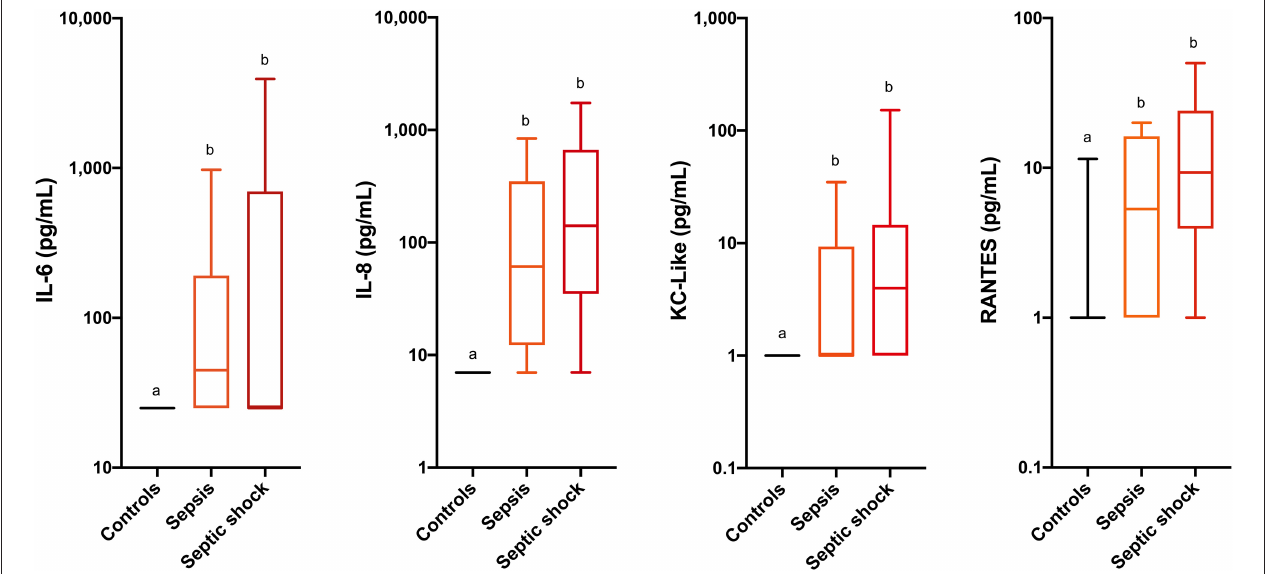
FIGURE 1 | Box and whisker plots for the concentrations of interleukin-6 (IL-6), interleukin-8 (IL-8), keratinocyte-chemoattractant-like (KC-Like) and Regulated upon Activation, Normal T cell Expressed, and Secreted (RANTES) in healthy cats, cats with sepsis, and cats with septic shock. Concentrations sharing a letter code annotation were not significantly different, while those not sharing a letter code were significantly different. For cytokines with measured concentrations below those covered by the standard curve, values for the assay lower limit of detection were imputed. Hence the figures appear truncated due to imputation of the lower limits of detection. Note the logarithmic scales of the